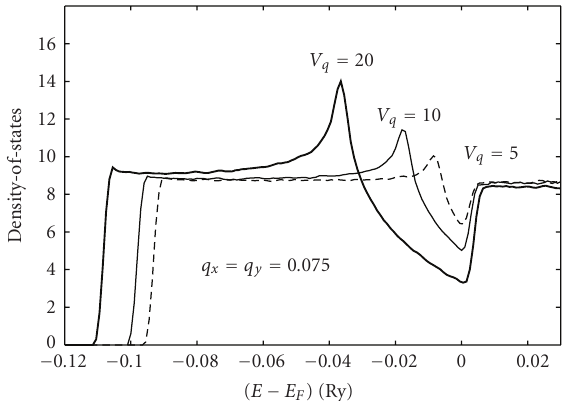
Figure 2: Examples of the DOS from the 2D NFE model for 3 di ff erent strengths of V q (in mRy) for